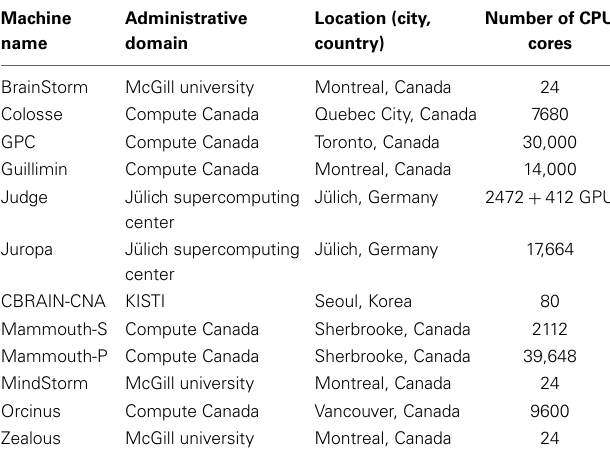
Table 1 | CBRAIN high performance clusters and